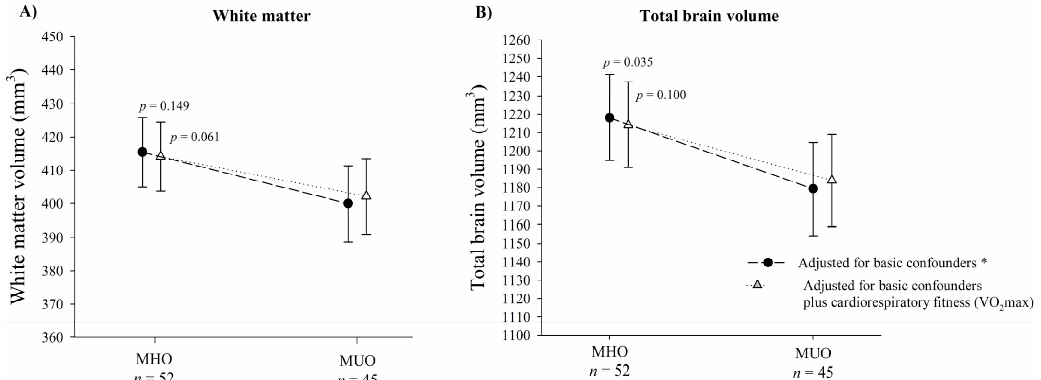
Figure 2. Differences in global white matter ( A ) and total brain volume ( B ) between metabolically healthy and metabolically unhealthy overweight/obesity. MHO: Metabolically healthy overweight/obesity. MUO: Metabolically unhealthy overweight/obesity. * Basic confounders were sex, peak height velocity (years), parental education level (none/one/both of them), and body mass index (kg/m 2 ).